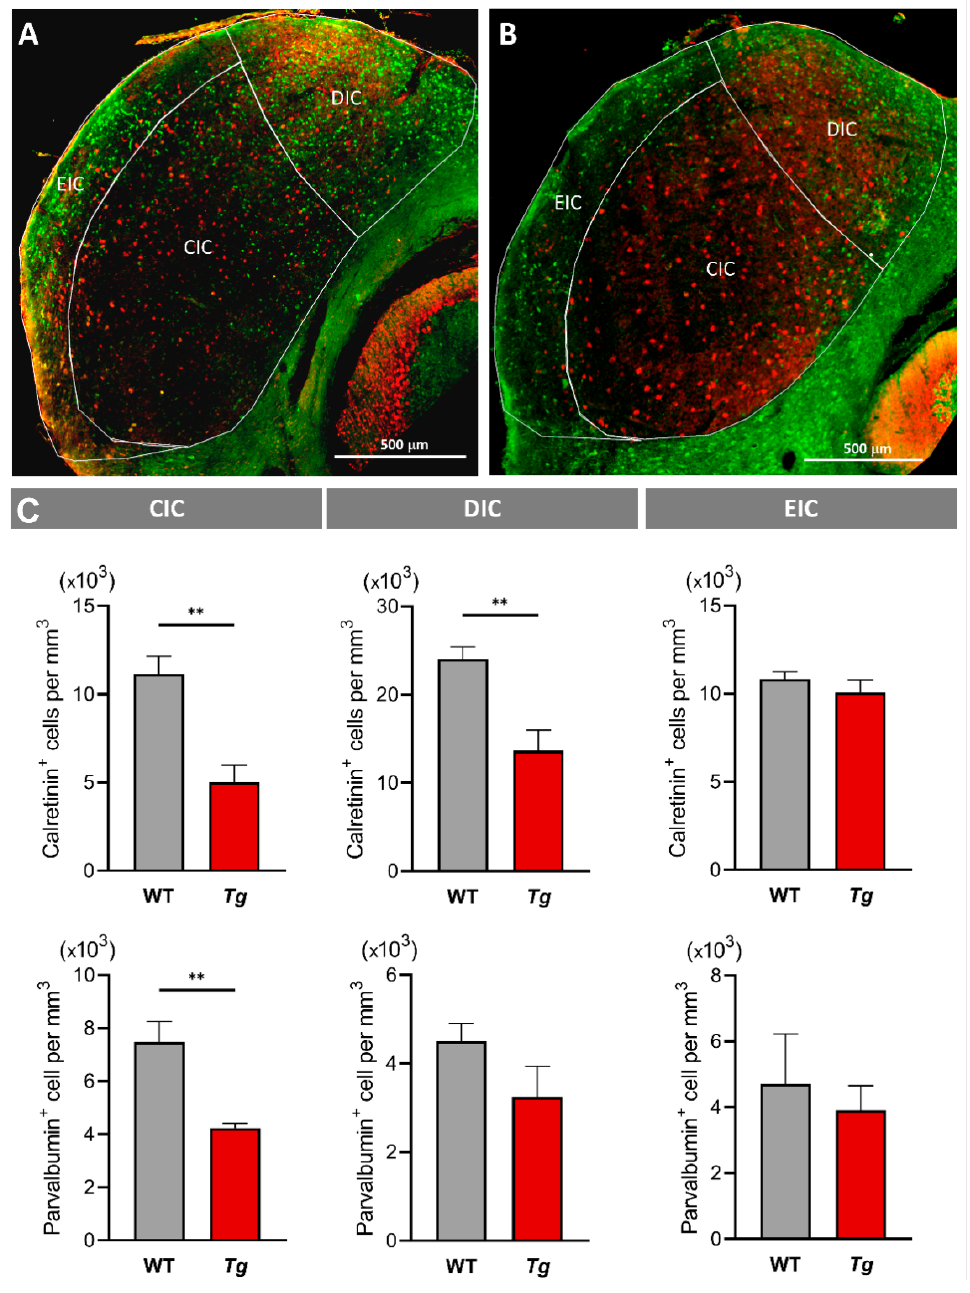
Figure 8. Calcium binding proteins in the IC. ( A , B ) Illustration of immunofluorescent staining of the coronal brain section with anti-calretinin (green) and anti-parvalbumin (red) staining in WT ( A ) and Tg ( B ) mice. Delineations show central (CIC), dorsal (DIC), and external (EIC) nuclei of the IC. ( C ) Number of calretinin and parvalbumin positive cells in the IC nuclei. Mean ± SD, unpaired t -test, ** p <